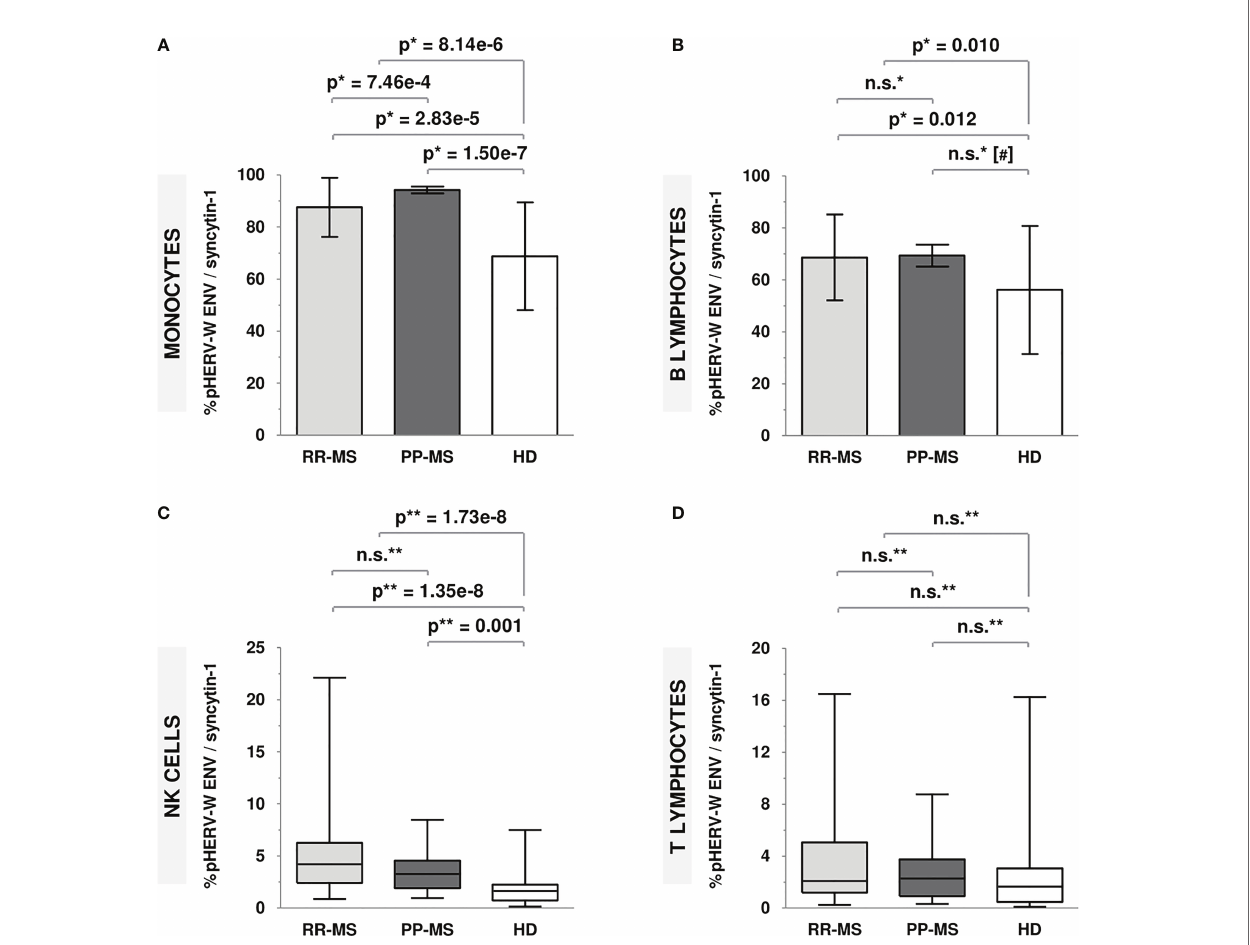
FIGURE 1 | Protein expression levels of pHERV-W ENV/syncytin-1 in RR-MS patients, PP-MS patients and HD. (A) Monocytes (mean ± SD): RR-MS = 87.54 ± 11.36; PP-MS= 94.24 ± 5.97; HD = 68.76 ± 20.70. (B) B lymphocytes (mean ± SD): RR-MS = 68.64 ± 16.53; PP-MS = 69.32 ± 18.98; HD = 56.12 ± 24.65. (C) NK cells [median (P25-P75)]: RR-MS = 4.19 (2.40-6.25); PP-MS = 3.26 (1.92-4.55); HD = 1.63 (0.74-2.24). (D) T lymphocytes [median (P25-P75)]: RR-MS = 2.08 (1.19-5.07); PP-MS = 2.29 (0.92-3.75); HD = 1.67 (0.48-3.06). [*t-Student test; **Mann-Whitney U test; (#) age-adjusted p-value; n.s., not signi fi